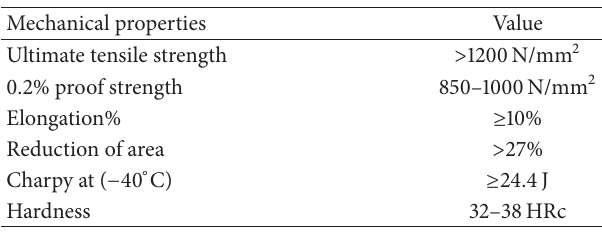
Table 2: Mechanical properties for H-steel material according to DEFSTAN 10-13/2005.